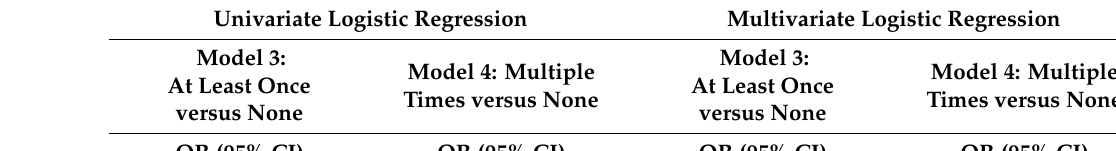
Table 4. Models of participation in bullying among school-age children in Serbia,